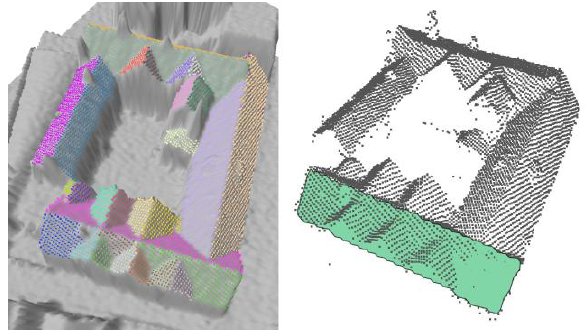
Figure 1. Segmentation of a complex building (left) and segment resulting from sub-surface growing (right).